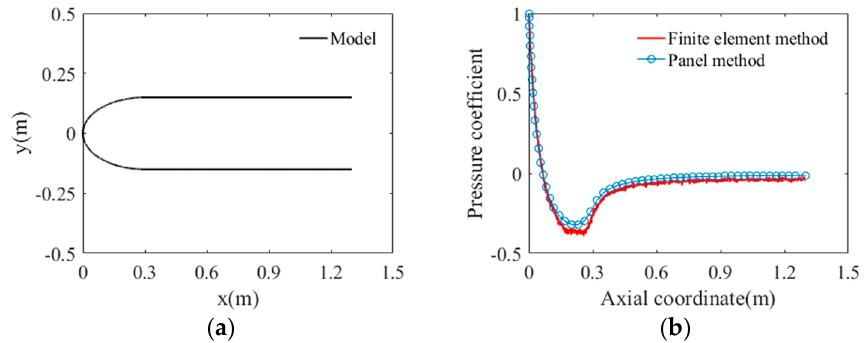
Figure 2. Partial view of the axisymmetric body model and its corresponding pressure coefficient.